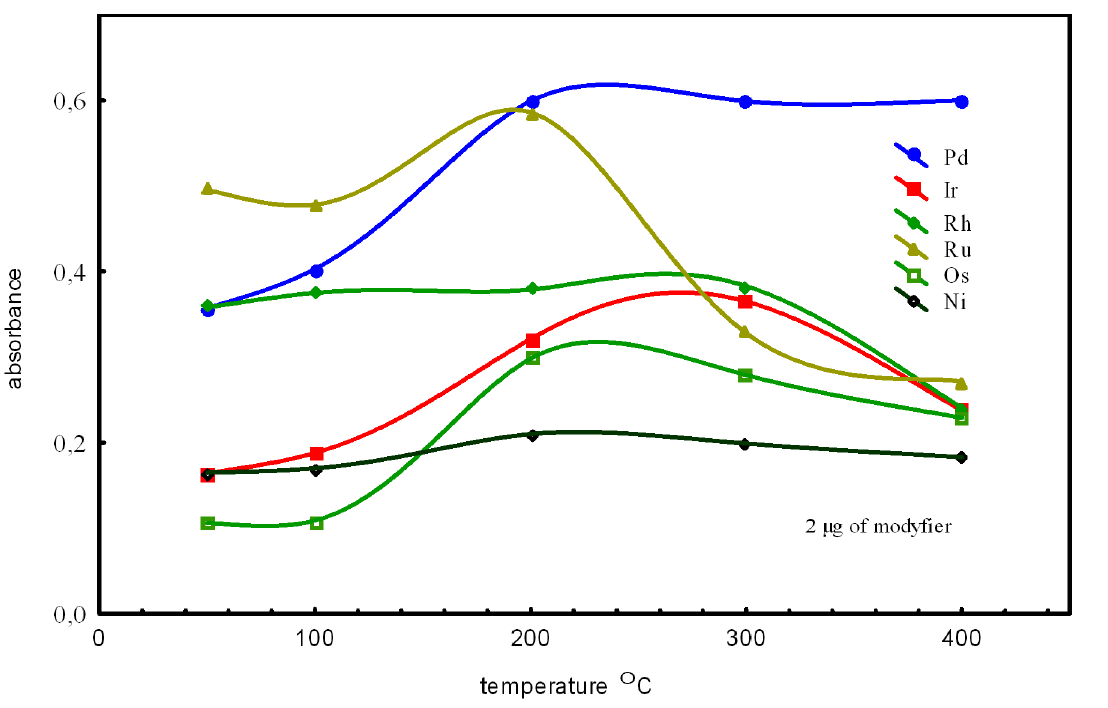
Fig. 1 The dependence of the analytical signal on temperature using in-situ selenium trapping in graphite tube (standard 10